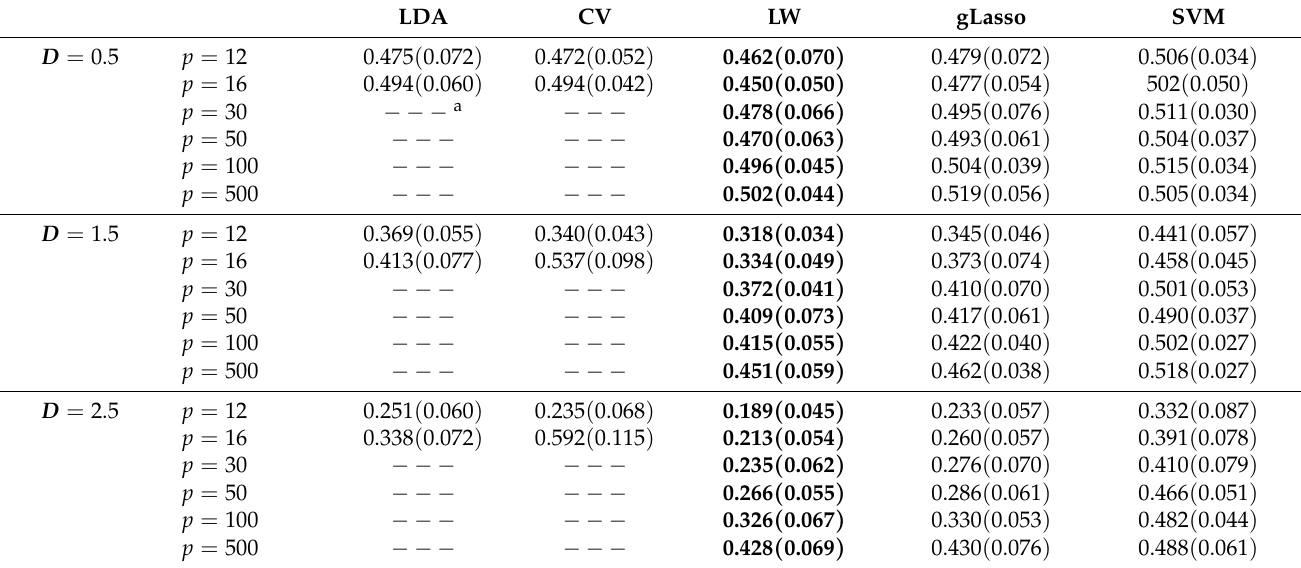
Table 3. Misclassification error and shrinkage parameter values for ρ = 0.4 in Mod1 state.